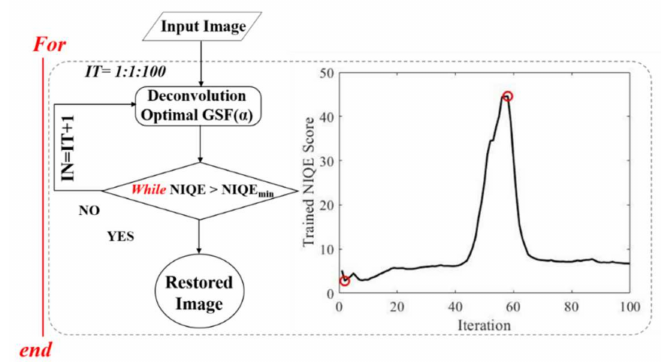
Figure 5. Step #2 of the